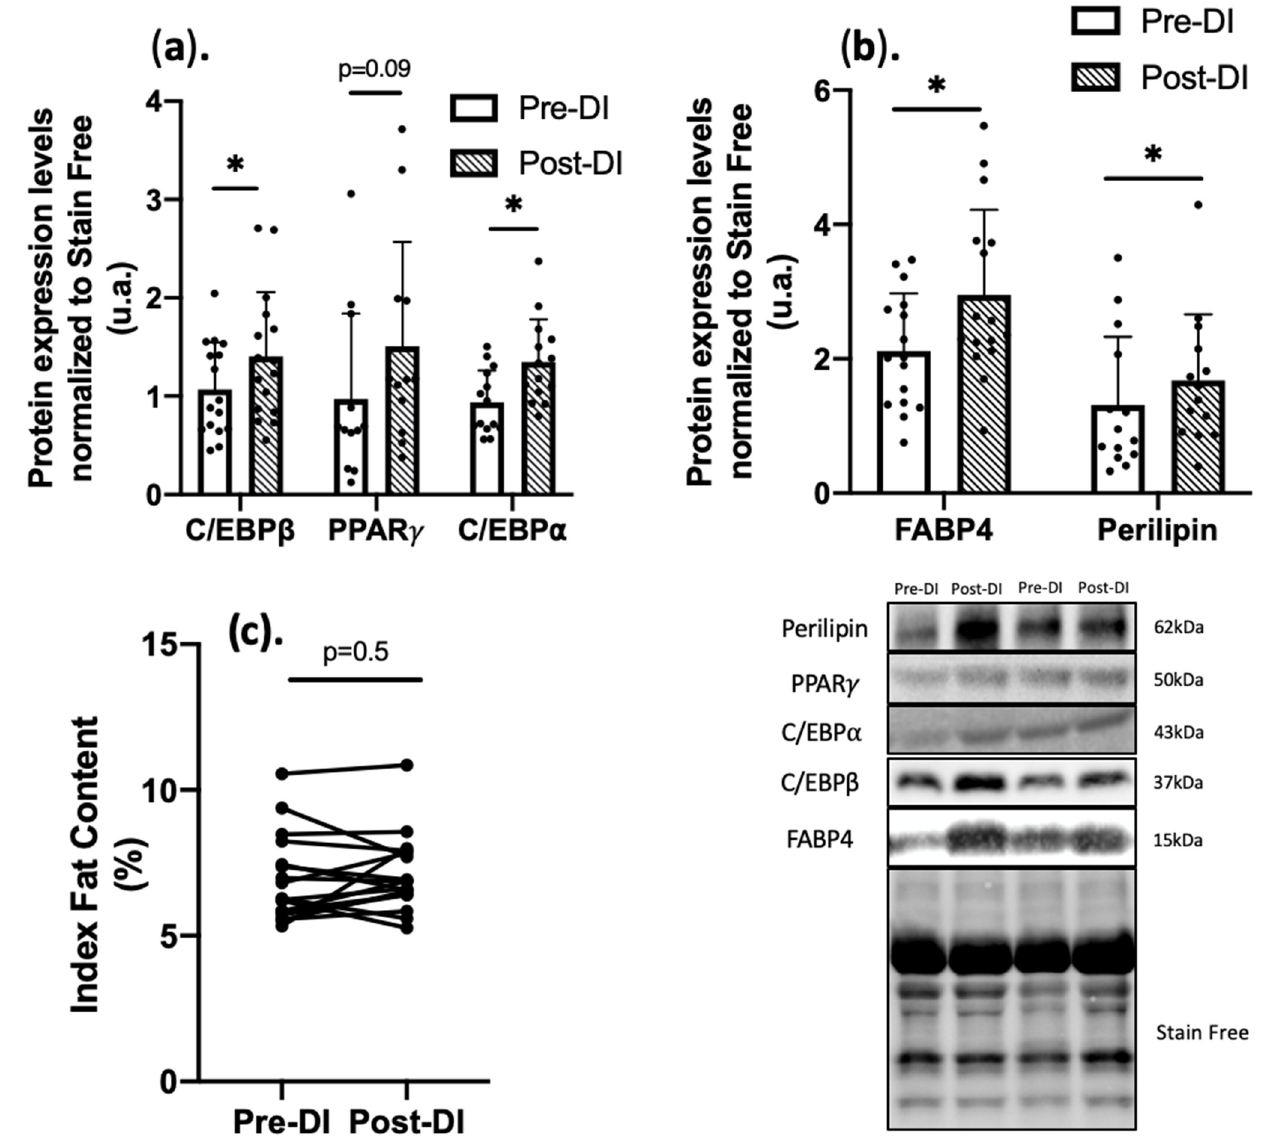
Figure 5. Expression of adipogenic differentiation markers in muscle from VL biopsies before (Pre- DI) and after (Post-DI) 5 days of DI. ( a ) Protein levels of key adipogenic markers in Pre-DI and Post-DI vastus lateralis biopsies. Data were normalized to the total protein staining using Stain-free technology ( b ) Protein levels of two mature adipocyte markers in Pre-DI and Post-DI vastus lateralis biopsies; data were normalized to the total protein staining using Stain-free technology. n = 16/time point for C/EBP β , FABP4; n = 14/time point for C/EBP ⍺ , Perilipin; n = 12/time point for PPARg ( c ) Index Fat Content individual percent of Vastus lateralis measured by MRI before (Pre-DI) and after (Post-DI) 5 days of DI. * p < 0.05, Paired t- test or Wilcoxon matched-pairs signed-rank test was per- formed according to normality.